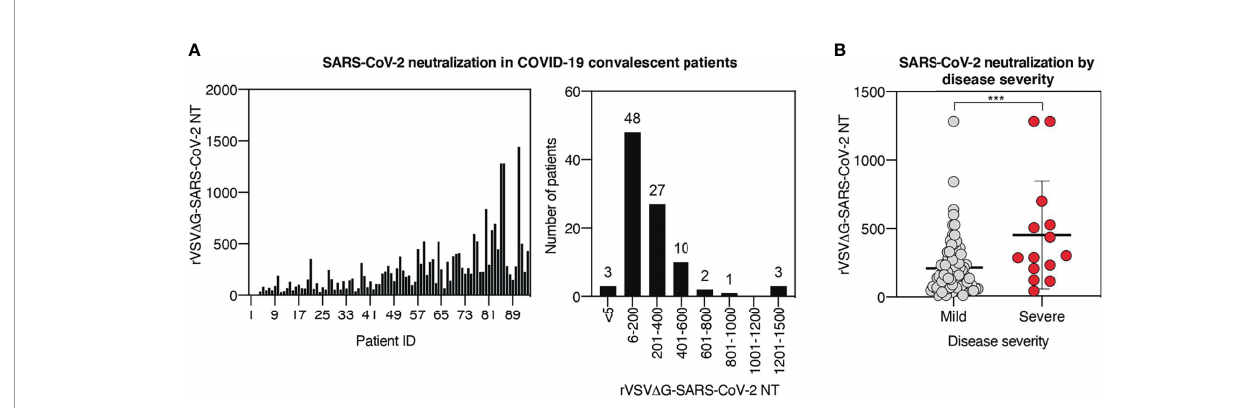
FIGURE 3 | Neutralization titer broadly differs among COVID-19 recovered patients and correlates with the severity of symptoms. (A) rVSV D G-SARS-CoV-2 neutralization titers in serum samples from the cohort. Results are displayed by patient ID (left panel) and in histogram plot indicating cohort distribution by neutralization titers (right panel). (B) Plot displaying rVSV D G-SARS-CoV-2 neutralization titers in patients strati fi ed by disease severity. Each symbol represents one patient. For each group, the mean ± SD is indicated; *** indicates p <